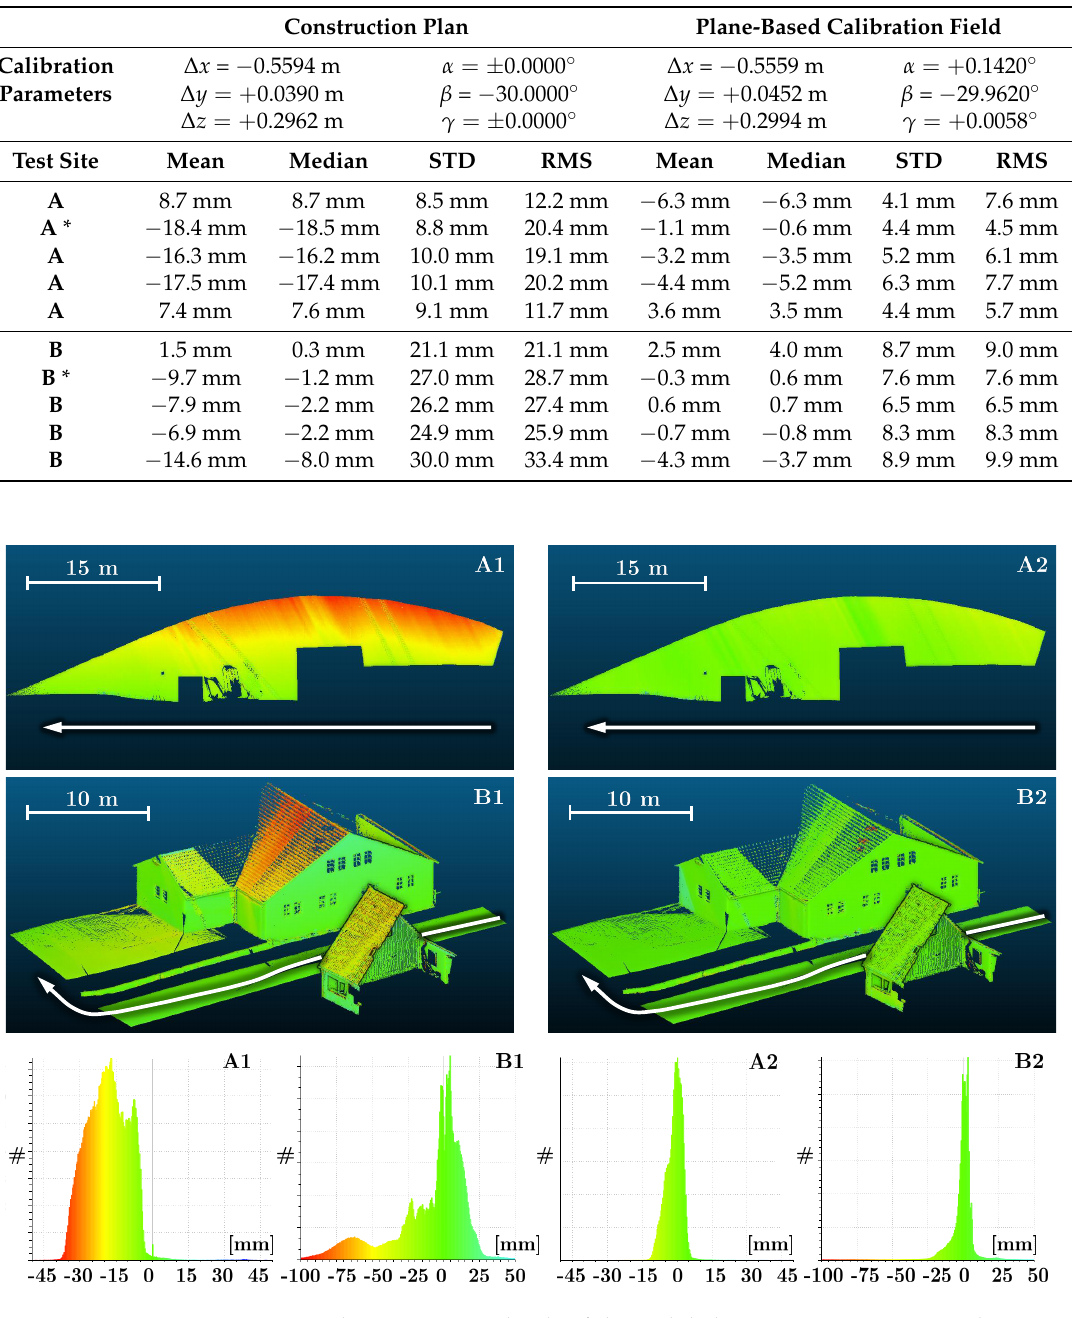
Figure 17. M3C2 comparison between point clouds of the mobile laser scanning system and TLS reference point clouds by using calibration parameters taken from the construction plan (A1, B1, left column ) and from the plane-based calibration field (A2, B2, right column